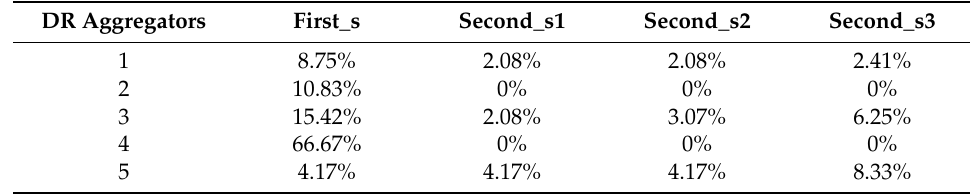
Table 11. Average absolute proportion of DR scheduled in each stage for each aggregator of the IEEE 118 case with transmission